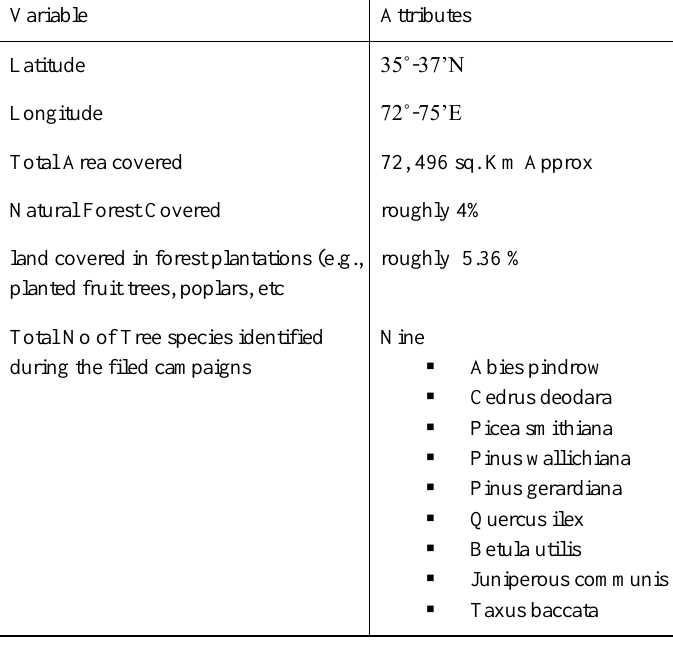
Table 1. Major Physical Characteristics of the